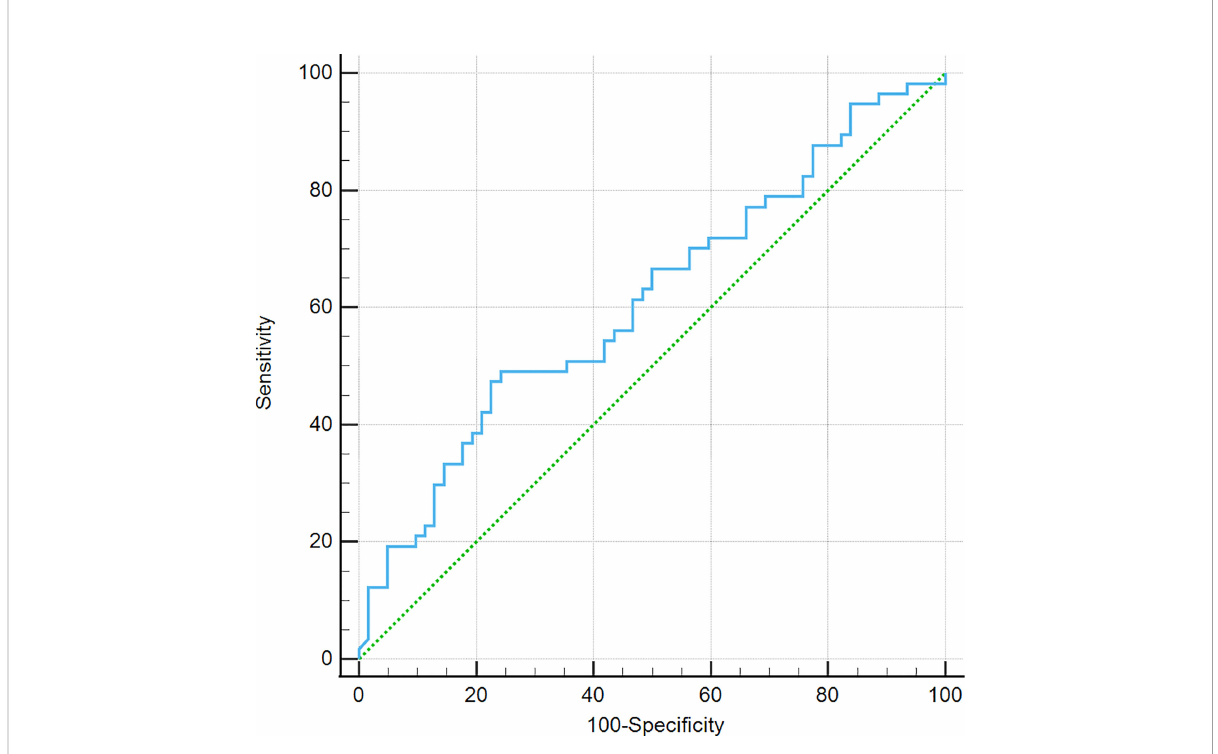
FIGURE 4 ROC curve analysis. It was found that prolactin value is of diagnostic value for EPPHS through the analysis of work curve (ROC